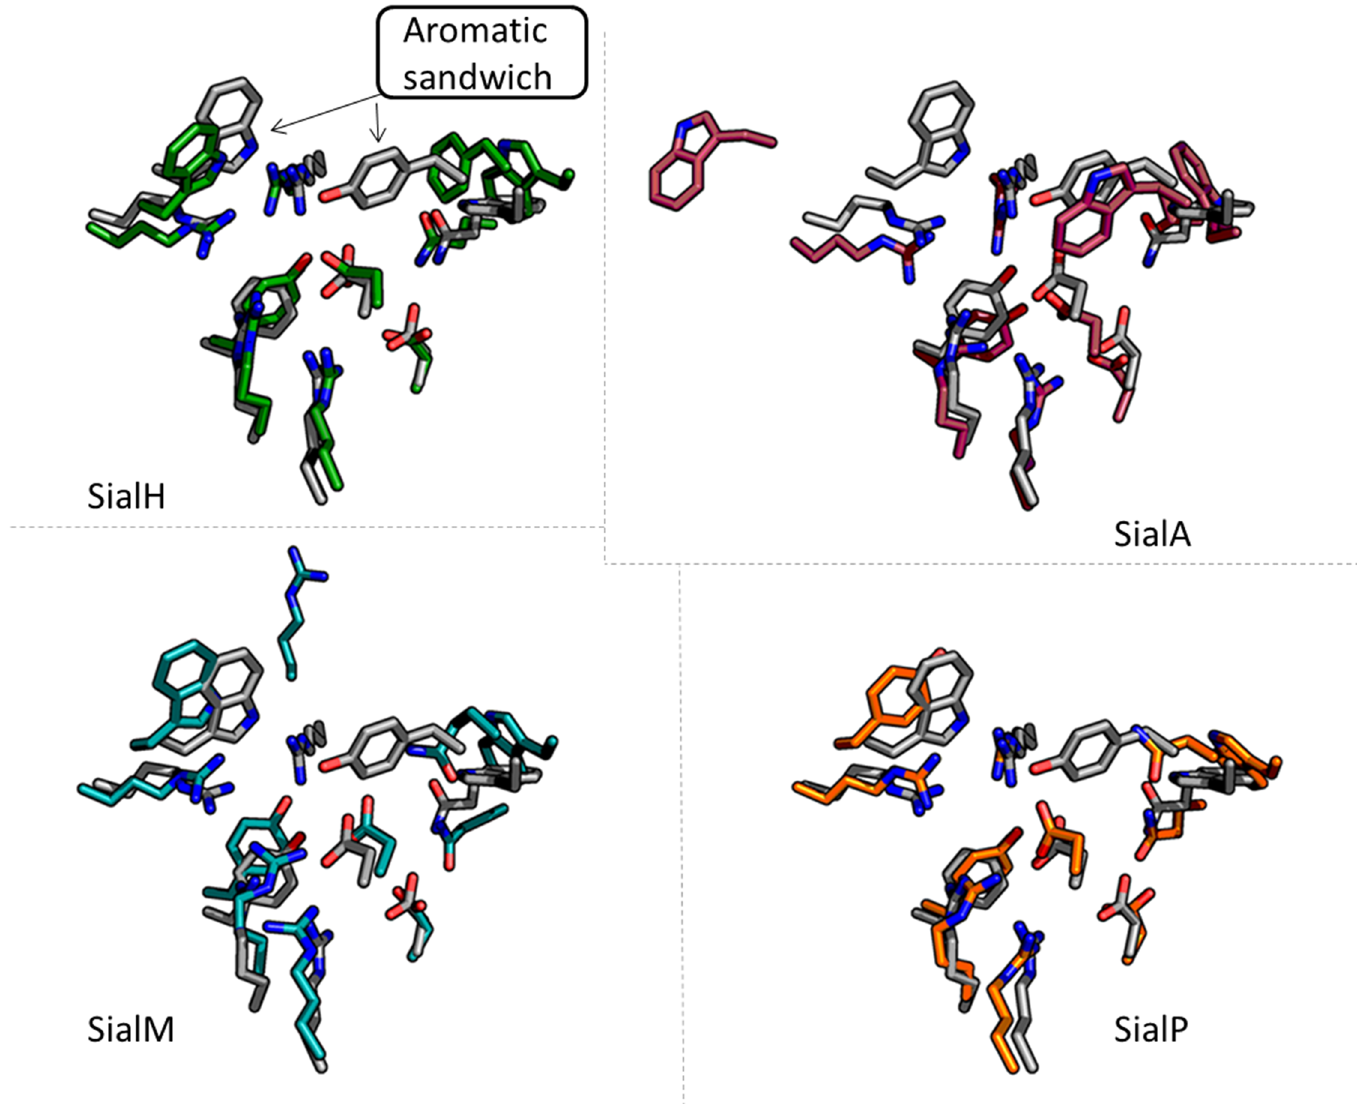
Fig 2. Homology modeling of active sites of the four selected trans-sialidase candidates. The four enzyme candidates selected for in vitro testing, SialH (green), SialA (red), SialM (blue), and SialP (orange), were modeled by homology modeling using TcTS as the template (gray). The active site and aromatic sandwich residues (indicated in TcTS with arrows in the SialH figure) are shown. The four candidates were selected based on two criteria: 1) restoration of the active site with its nine sialyl interacting residues, and 2) the formation of a narrow (closed) binding cleft above the active site, preferably with an aromatic sandwich composed of two aromatic amino acid residues. Whereas all of the selected candidates were predicted to have sterically closed active sites, SialH was the only candidate predicted to display an aromatic sandwich. The aromatic sandwich of SialH is comprised of W366 and F168 and aligns (in the model) almost perfectly to the one found in